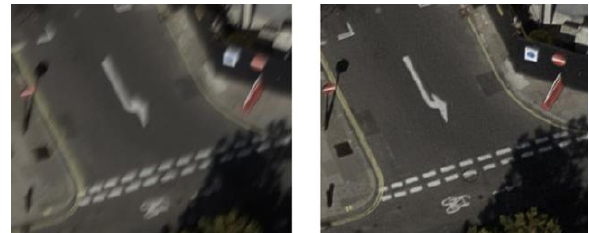
Figure 3b : Street details of one large scale oblique image (cf. Figure 3 a). Strong angular motion blur at about 11 pixel exists in the raw image data (cf. left image) and this was successfully compensated by AMC (cf. right image)